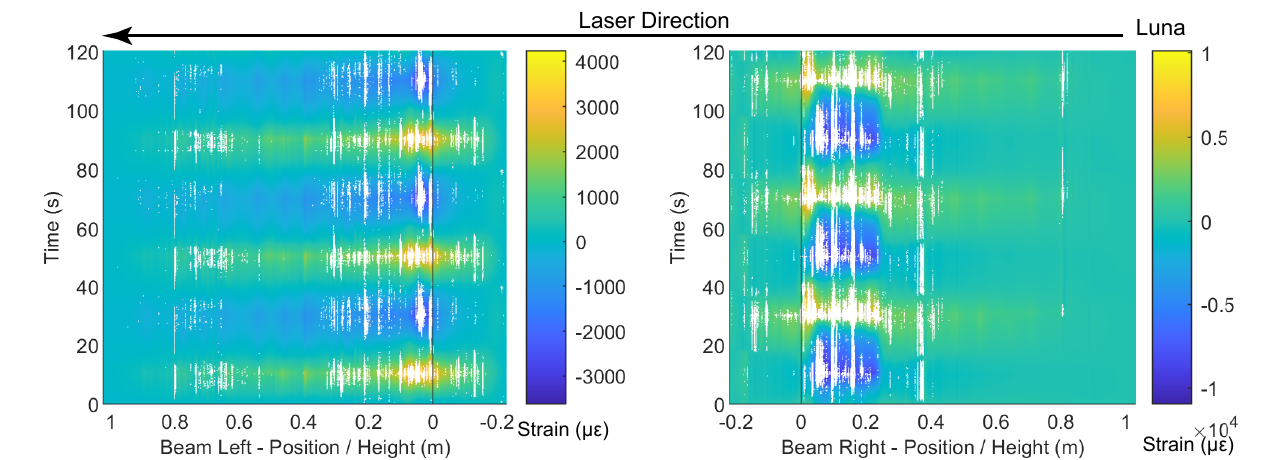
Figure 18. Contour of the fiber-optic strain measurements for polyimide cable (in rebar) at a drift level of 0.95%.